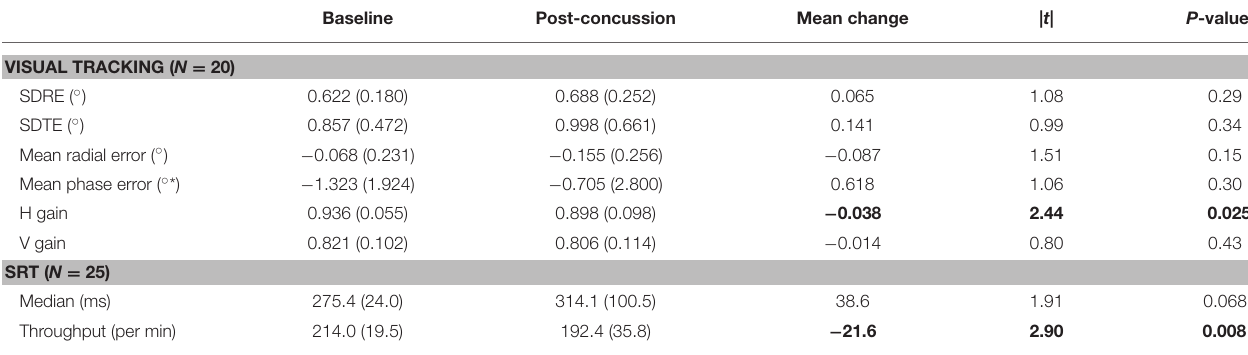
TABLE 1 | Within-individual changes from the baseline in visual tracking and reaction time performances within 2 weeks after a concussion. Baseline Post-concussion Mean change